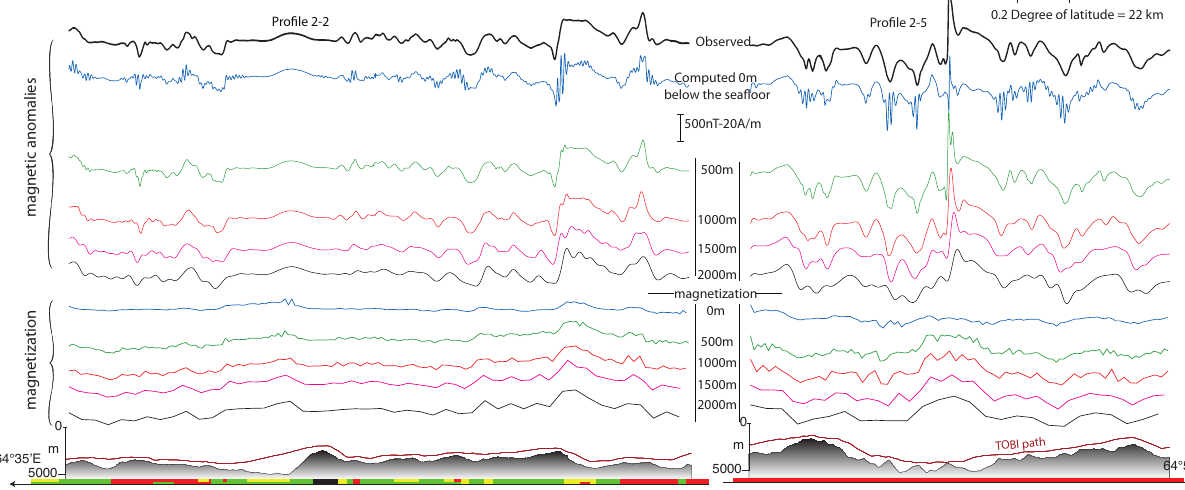
Figure 6. Comparison between the deep-tow observed magnetic field, along profiles 2–2 and 2–5, and the magnetic computed field along the TOBI path for different depths of inferred magnetized dipoles from 0 to 2000m below the seafloor. In the lower panel, the magnetization solution is also reported along the same profiles for different depths. The shallowest and deepest dipoles lead respectively to the appearance of high frequency oscillations in the computed field and loss of resolution in both the computed field and the magnetization solution. The best compromise is found for dipoles located around 500m below the seafloor for profile 2–5 acquired above the volcanic crust and 1000m for profile 2–2 collected above the exhumed mantle-derived rocks. A significant loss in resolution is observed for dipoles located below 1000m in the case of the volcanic crust whereas both the computed field and the magnetization solution are quite well preserved up to 2000m for the case of exhumed mantle